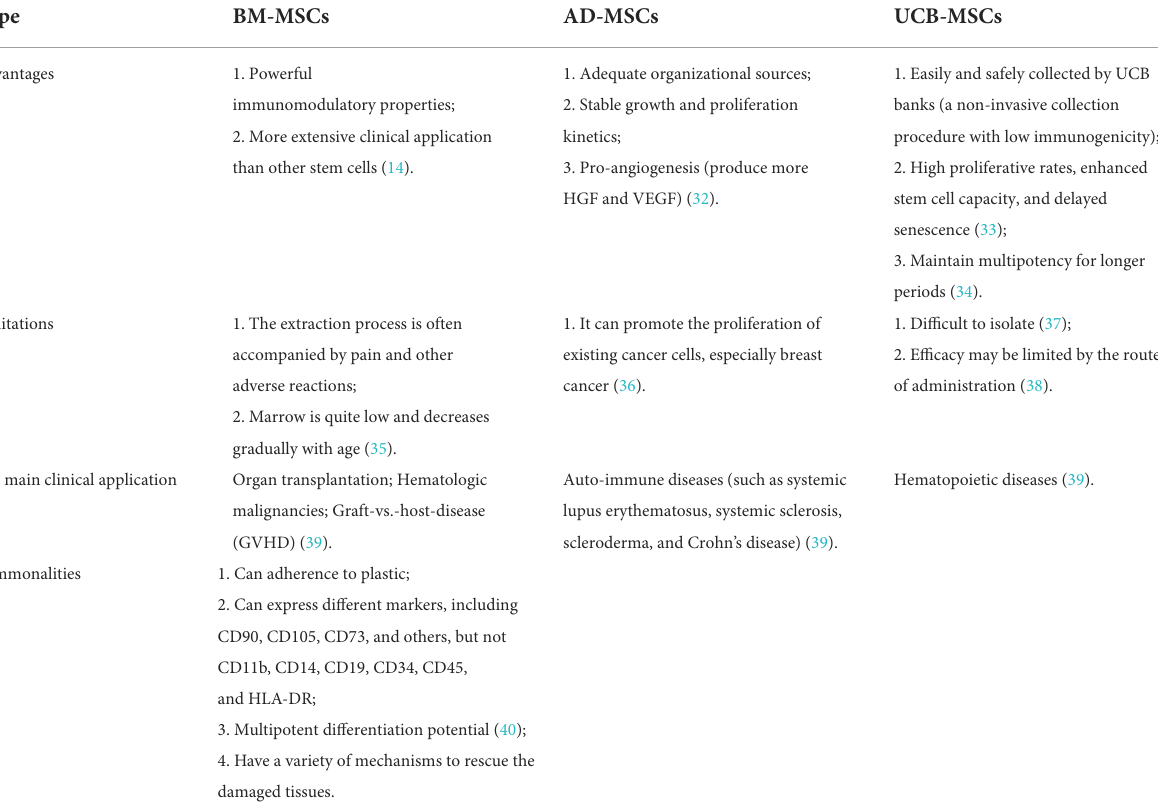
TABLE 1 Advantages and disadvantages of MSCs from different